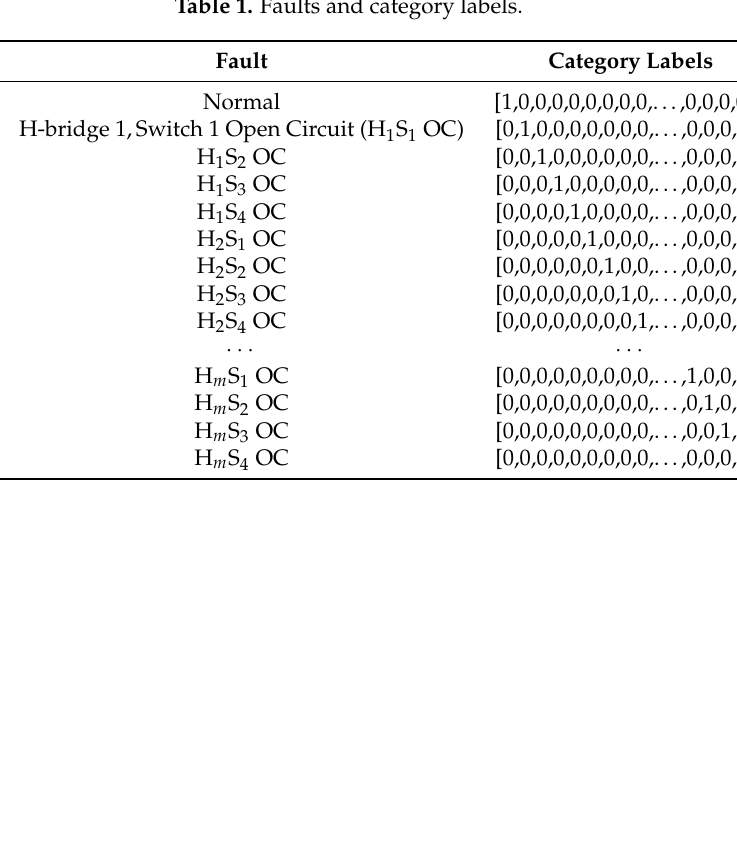
Figure 1. A Cascaded H-bridge Multilevel Inverter (CHMI) topology. Table 1. Faults and category